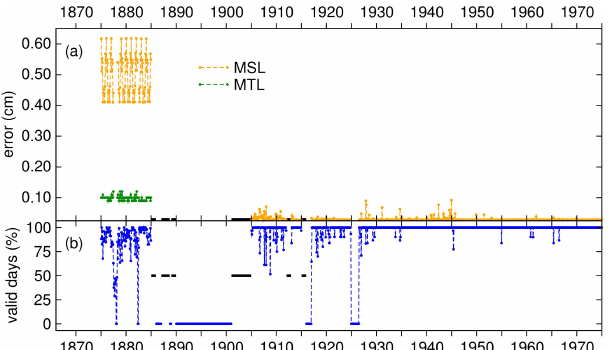
Figure 7. (a) Monthly errors (cm) for 1875–1975; both the errors in MTL and MSL are shown for 1875–1889. (b) Monthly percentages of valid days for 1875–1975. After 1975 the error is always 0.03cm, and there are no missing days. The black segments indicate that the errors and percentages of valid days are unknown. The labels on the abscissa axis refer to the beginning of the year.